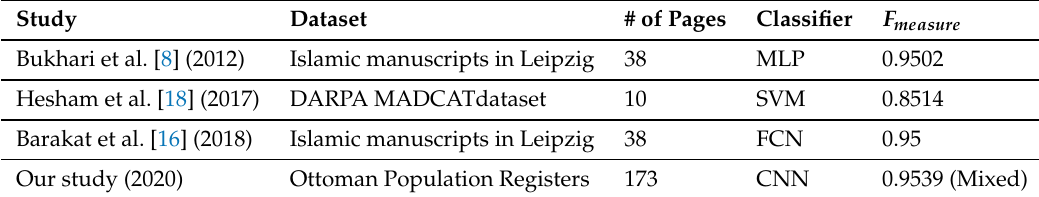
Table 6. Comparison of our results with different studies on Arabic historical document layout analysis. FCN stands for Fully-Convolutional